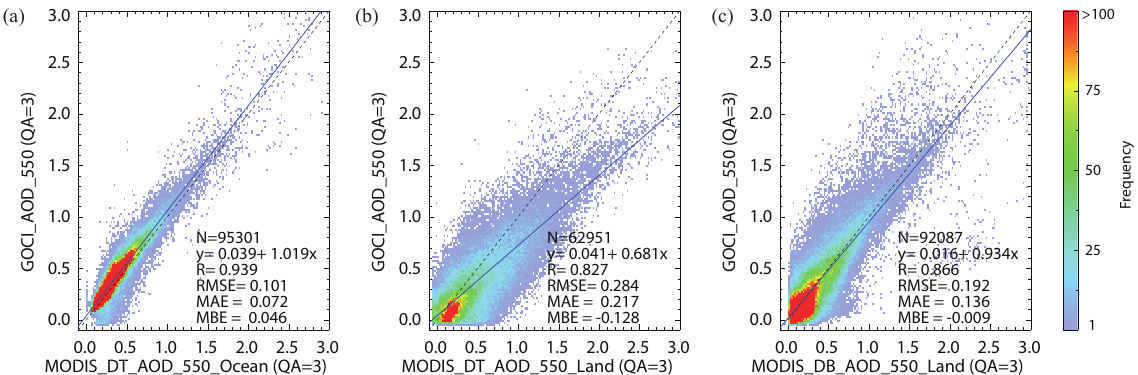
Figure 9. Comparison of AOD between (a) MODIS DT and GOCI over ocean, (b) MODIS DT and GOCI over land, and (c) MODIS DB and GOCI over land. Color pixels represent a bin size of 0.02. The blue solid line is the linear regression line. The black dashed line is the one-to-one